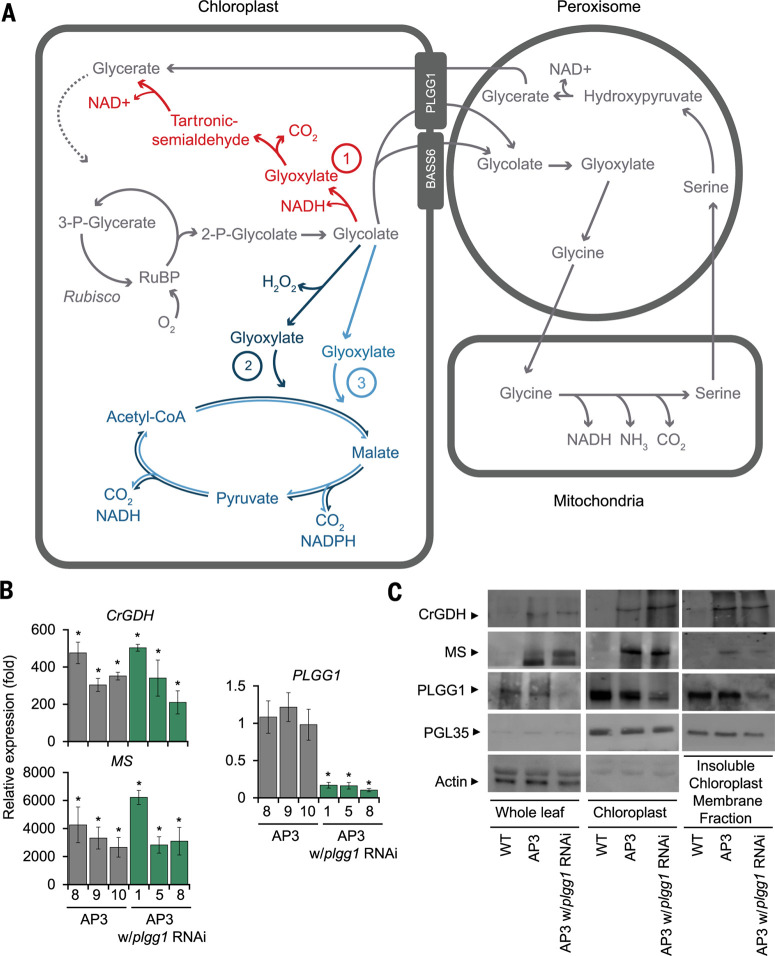
Alternative photorespiratory pathways. (A) Model of three alternative photorespiration pathway designs. API (red) converts glycolate to glycerate using five genes from the E. coli glycolate pathway encoding the enzymes glycolate dehydrogenase, glyoxylate carboligase, and tartronic semialdehyde reductase. AP2 (dark blue) requires three introduced genes encoding glycolate oxidase, malate synthase, and catalase (to remove hydrogen peroxide generated by glycolate oxidase). AP3 (blue) relies on two introduced genes: Chlamydomonas reinhardtii glycolate dehydrogenase and Cucurbita maxima malate synthase. (B) qRT-PCR analysis of the two transgenes in AP3 and the target gene PLGG1 of the RNAi construct. Results for three independent transformation events are shown with (1, 5, and 8) and without (8, 9, and 10) PLGG1 RNAi. Error bars indicate SEM. * indicates statistical difference at P < 0.05 compared to WT based on one-way ANOVA. Actual P values are shown in supplementary data set 15. (C) Immunoblot analysis from whole leaves and isolated chloroplasts, including the insoluble membrane fraction, using custom antibodies raised against the indicated target genes, cytosolic marker actin, and chloroplast-specific marker platoglobulin 35 (PGL35). Five micrograms of protein was loaded per lane. Arrows indicate detected protein based on molecular weight. The kinetic properties of CrGDH, as well as numerous malate synthase enzymes, have been previously characterized (table S3) (17).